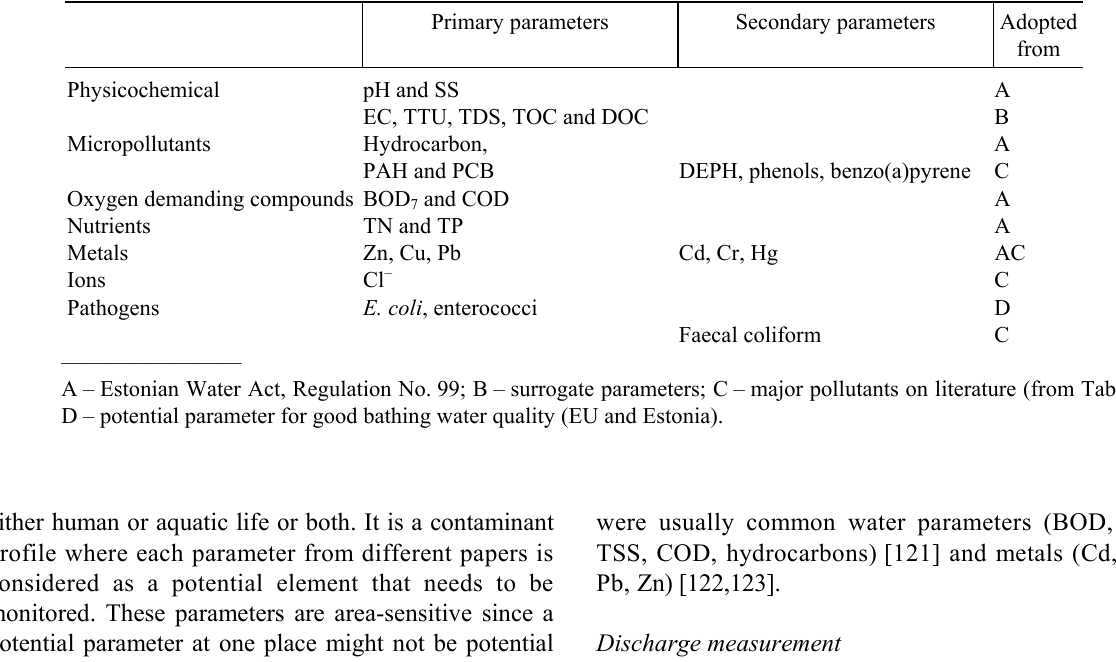
Table 7. Recommended parameters for the monitoring programme in